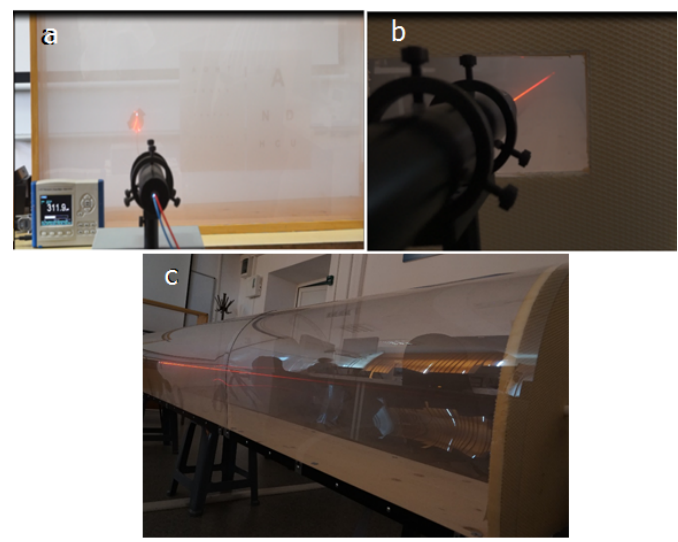
Figure 15. Impact on laser beam for ( a ). Fog layer of 30 cm ( b ) and ( c ). Uniform fog of 3 m (seen from two positions).